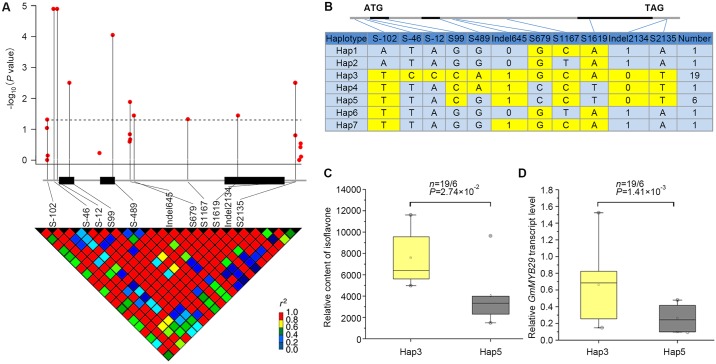
Natural variations in GmMYB29 are significantly associated with total isoflavone contents in soybean.(A) GmMYB29-based association mapping and pairwise LD analysis. The red dots above the dashed horizontal line represent significant variants (P < 0.05), which are connected to the pairwise LD diagram with a solid line. (B) Haplotypes of GmMYB29 among soybean natural variations. The haplotype is displayed as a linear combination of alleles (S-102, S-46, S-12, S99, S489, Indel645, S679, S1167 S1619, Indel2134 and S2135), and only the observed haplotypes are exhibited. The colored cells represent the favorable alleles. (C) Comparison of isoflavone contents between haplotypes Hap3 and Hap5. n denotes the genotype number of the two haplotypes. Statistical significance was detected by a two-tailed t-test. (D) Comparison of GmMYB29 expression between haplotypes Hap3 and Hap5. n is the number of genotypes of the two haplotype groups. Statistical significance was determined by a two-tailed t-test.